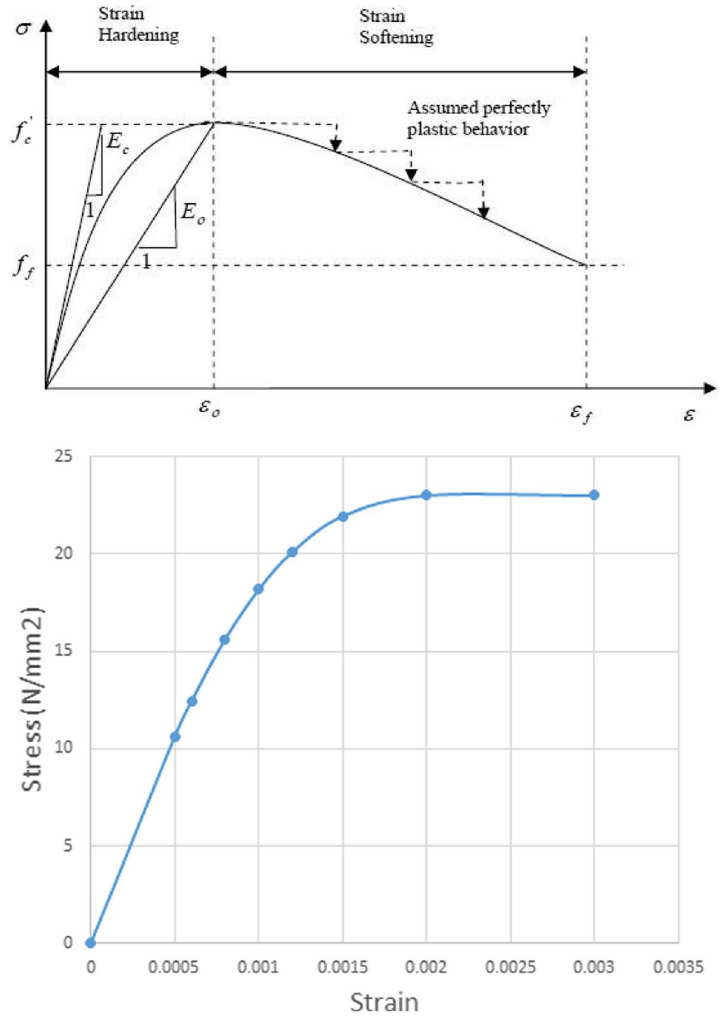
Fig. 13 Stress-strain curve under